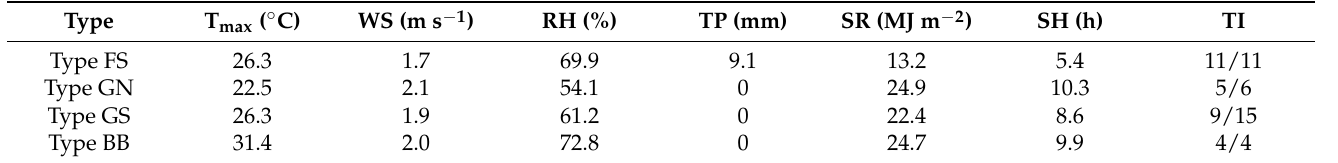
Table 3. The meteorological conditions in PT under each SWP during the springtime of